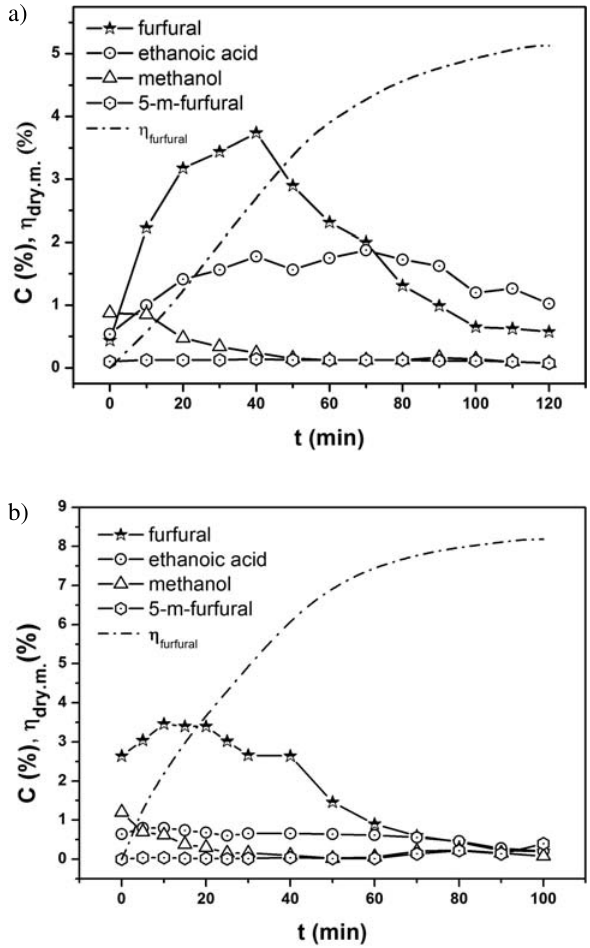
Figure 3. The composition of the outlet flow from the reactor and the furfural yield in a) non-catalysed process (process conditions: w =31.3%, T = 190 °C, P = 11.6 bar, S m,p catalysed process by dilute sulphuric acid (process conditions: w = 43.2%, w = 60%, T = 170 °C, P = 6.7 bar, S m,w g H